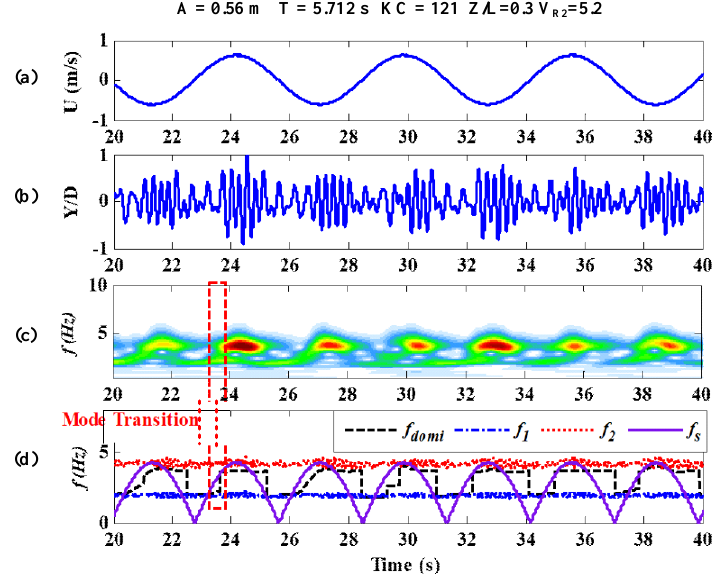
Figure 12. The time history of the VIV response and time–frequency distribution at Z/L = 0.5 for V R1 = 5.6 and KC = 121: ( a ) The forced motion velocity; ( b ) The VIV displacement response; ( c ) The time– frequency distribution of the VIV response; ( d ) The time-varying frequencies.